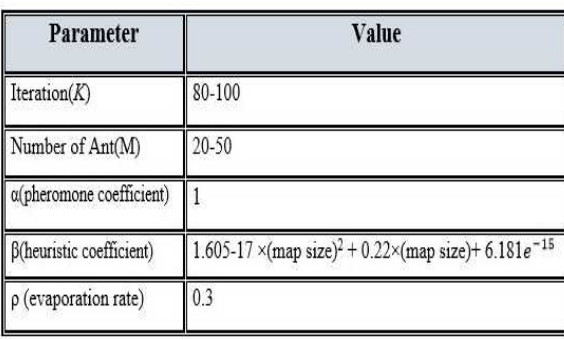
From the previous two figure, the mobile robot start avoids static obstacles with the shortest path is (15.07) in iteration (78) with the total computation time equal to (1.217323) sec.